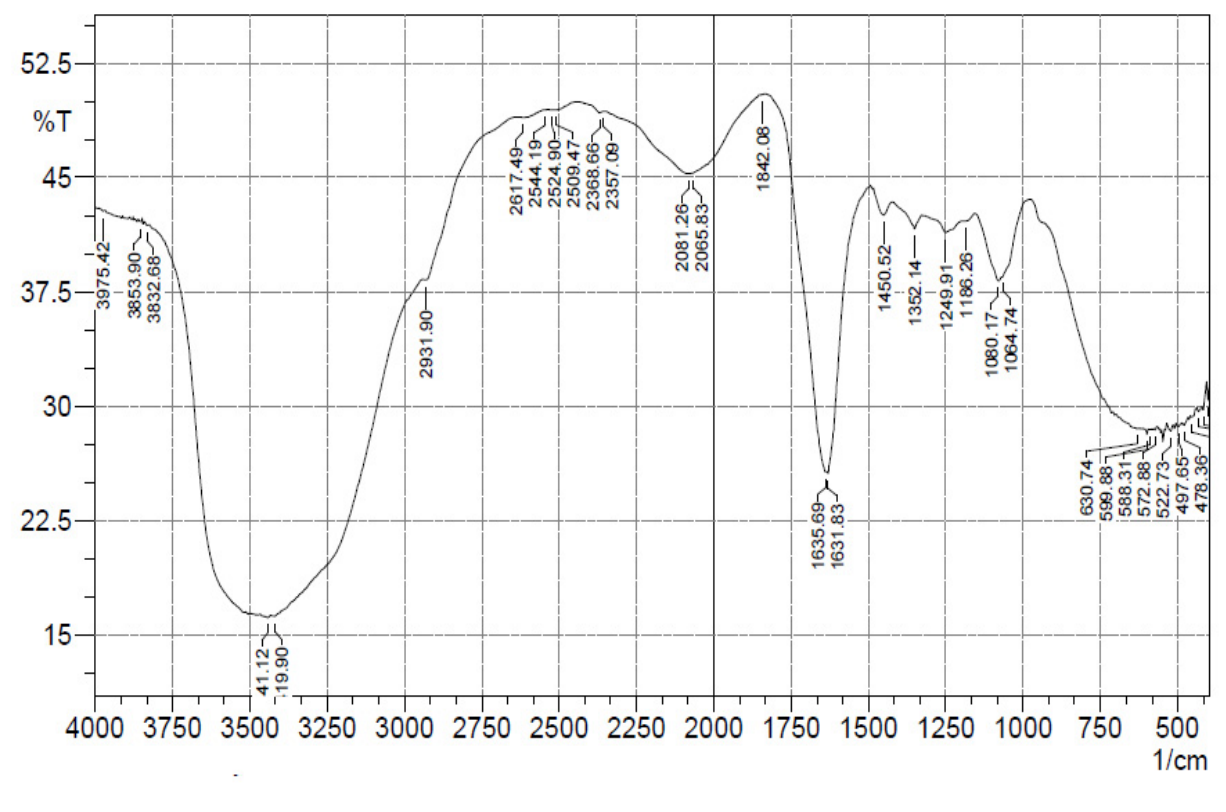
Figure 6. FTIR spectra of P. granatum ethosome gel (F9).